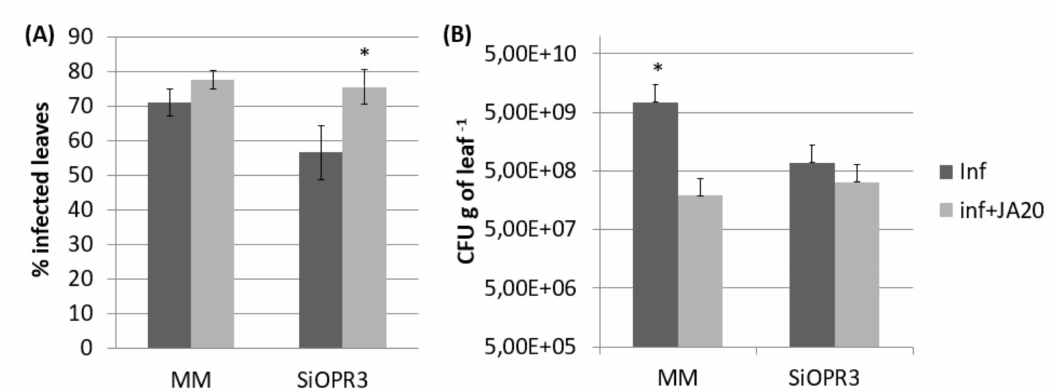
Figure 5. E ff ect of JA treatment on the response of MM and SiOPR3 transgenic plants to Pst . Disease symptoms were measured 72 h after infection in JA-treated and untreated plants as described in Figure 1. The percentage of dark brown spots on the leaf surface ( A ) and the bacterial populations ( B ) are shown. The data show the average values ± standard error ( n = 20). The asterisks represent statistically significant di ff erences ( p < 0.05; least-significant di ff erence